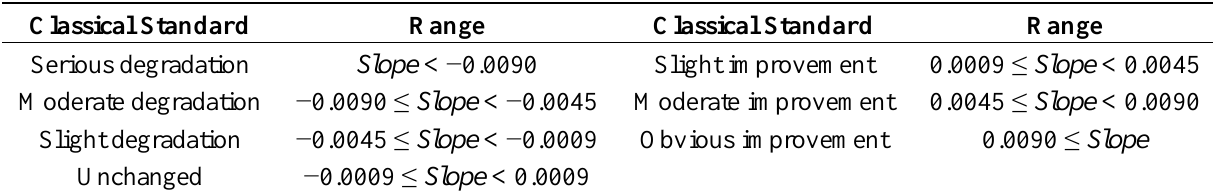
Table 1. Classical standards of NDVI